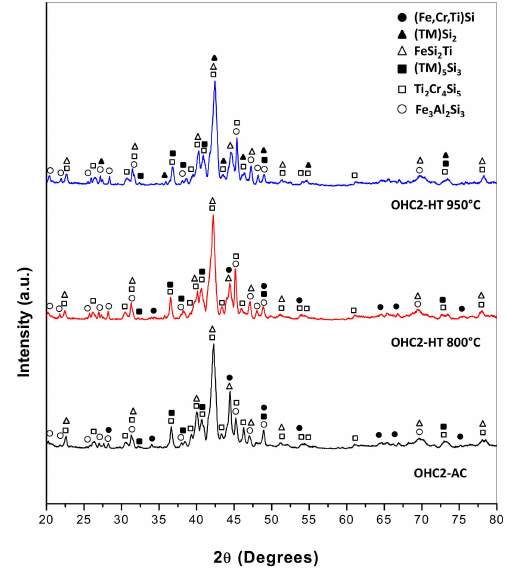
Figure 3. X-ray di ff ractograms of the cast and heat treated alloy